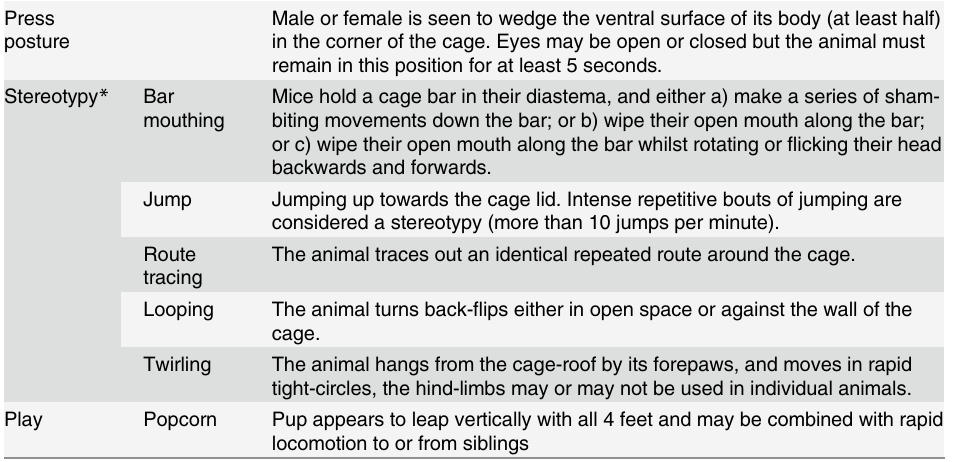
Table 4. Ethogram for 1/0 sampling. Press